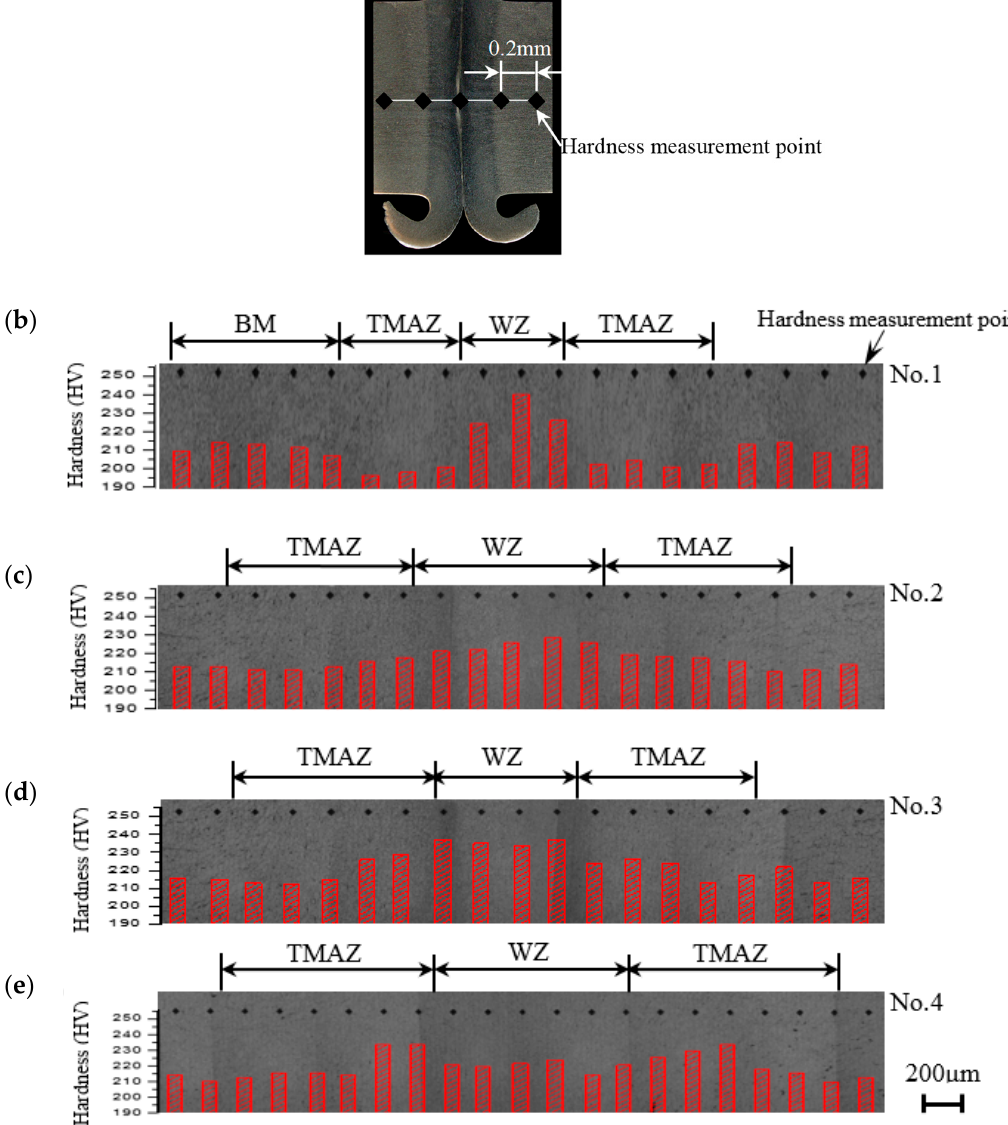
Figure 10. A diagram of the ( a ) microhardness test point and ( b – e ) microhardness distribution of specimens No.1–No.4.